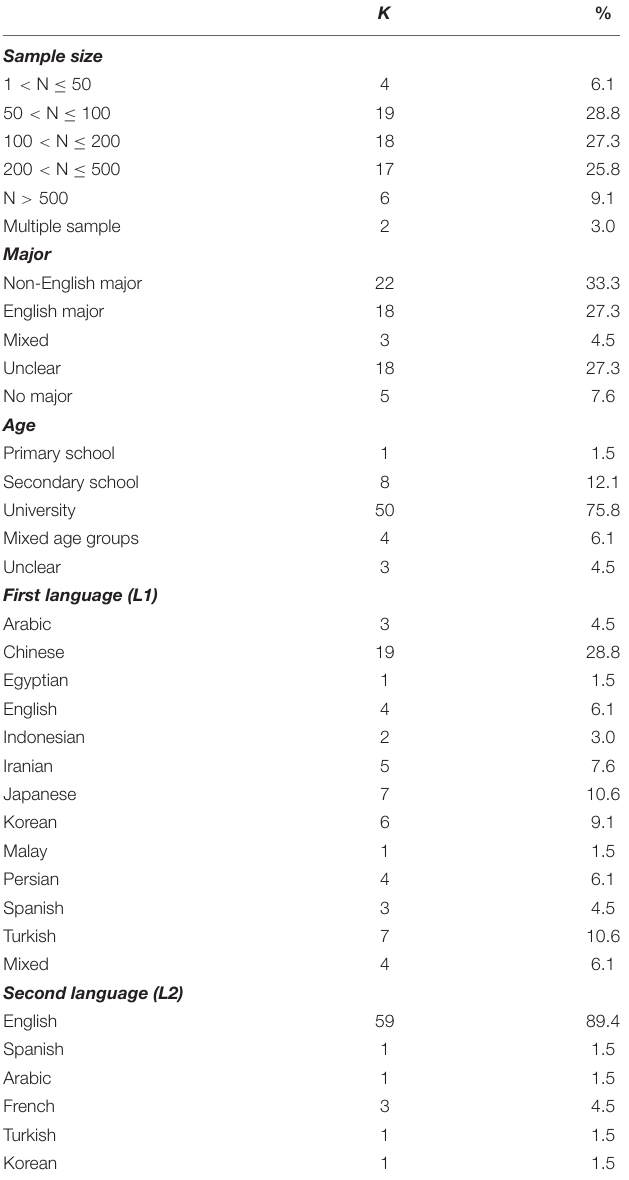
TABLE 5 | Participant characteristics and study context. TABLE 6 | In-depth review of studies by theme, method, and analysis